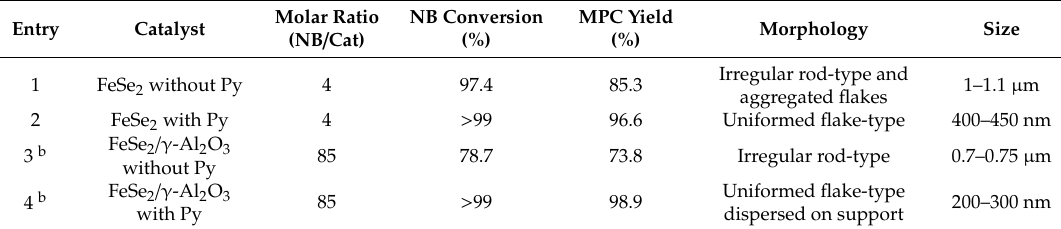
Figure 2. Scanning Electron Microscopy (SEM) images of ( a ) FeSe 2 prepared without pyridine, ( b ) FeSe 2 / γ -Al 2 O 3 prepared without pyridine, ( c ) FeSe 2 prepared with pyridine, and ( d ) FeSe 2 / γ -Al 2 O 3 prepared with pyridine. Table 3. Correlation between morphologies and activities a